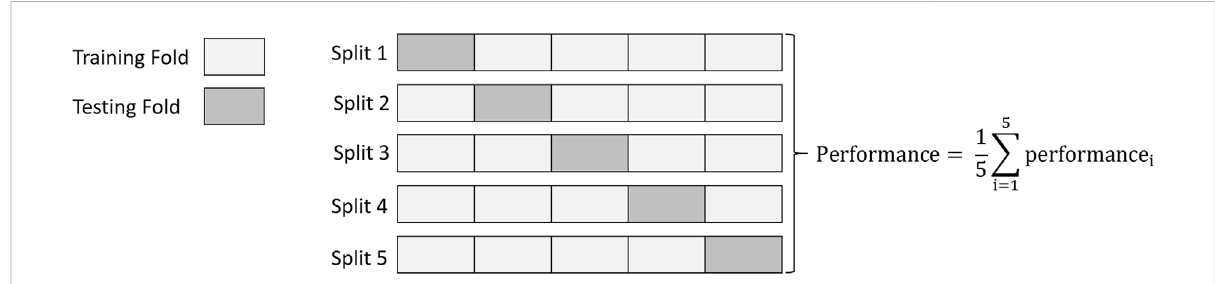
FIGURE 8 5-Fold cross-validation in which data is divided into 5-folds composed of 4-folds for training the model and 1-fold for validation. The overall performance is obtained by computing the arithmetic mean.